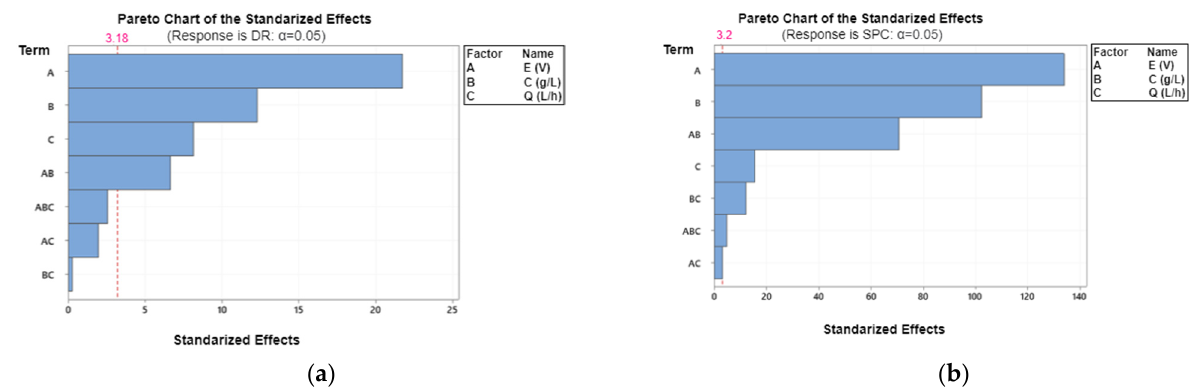
Figure 4. ( a ) Pareto chart for standardized effects for DR and; ( b ) SPC. Absolute effect sizes were plotted in descending order. The significance of the individual effect of each of the variables tested at the 0.05 level was designated using a reference line on both graphs so that effects above the reference line are statistically significant at the 95% confidence level [40].